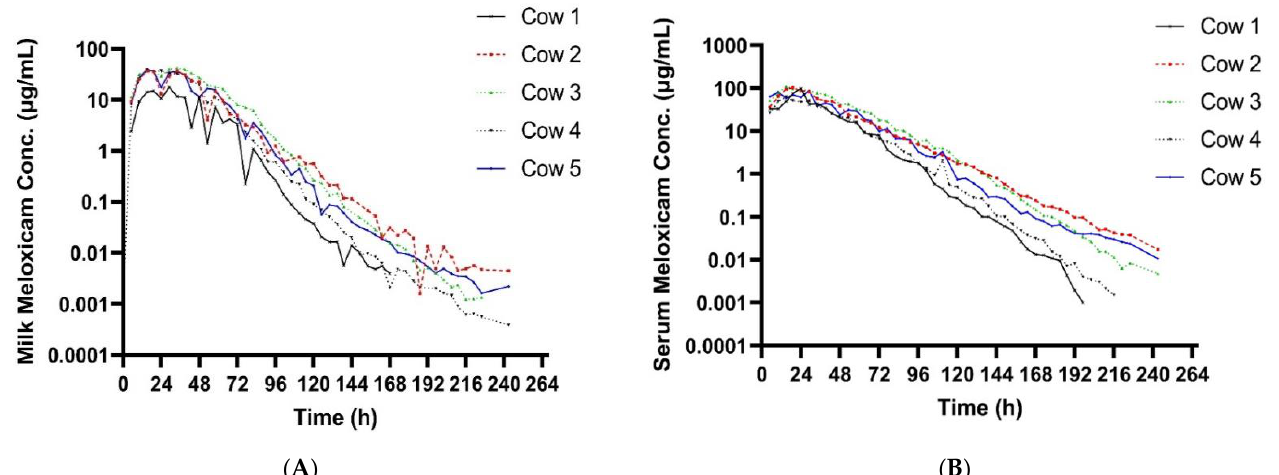
Figure 3. ( A ) Individual milk meloxicam concentrations for 5 cows administered meloxicam at 30 mg/kg PO at time zero. ( B ) Individual plasma meloxicam concentrations for 5 cows administered meloxicam at 30 mg/kg PO at time zero.